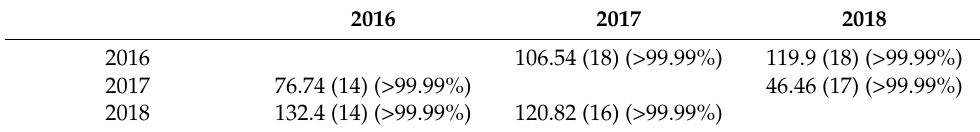
Table 1. The likelihood ratio test results of different years